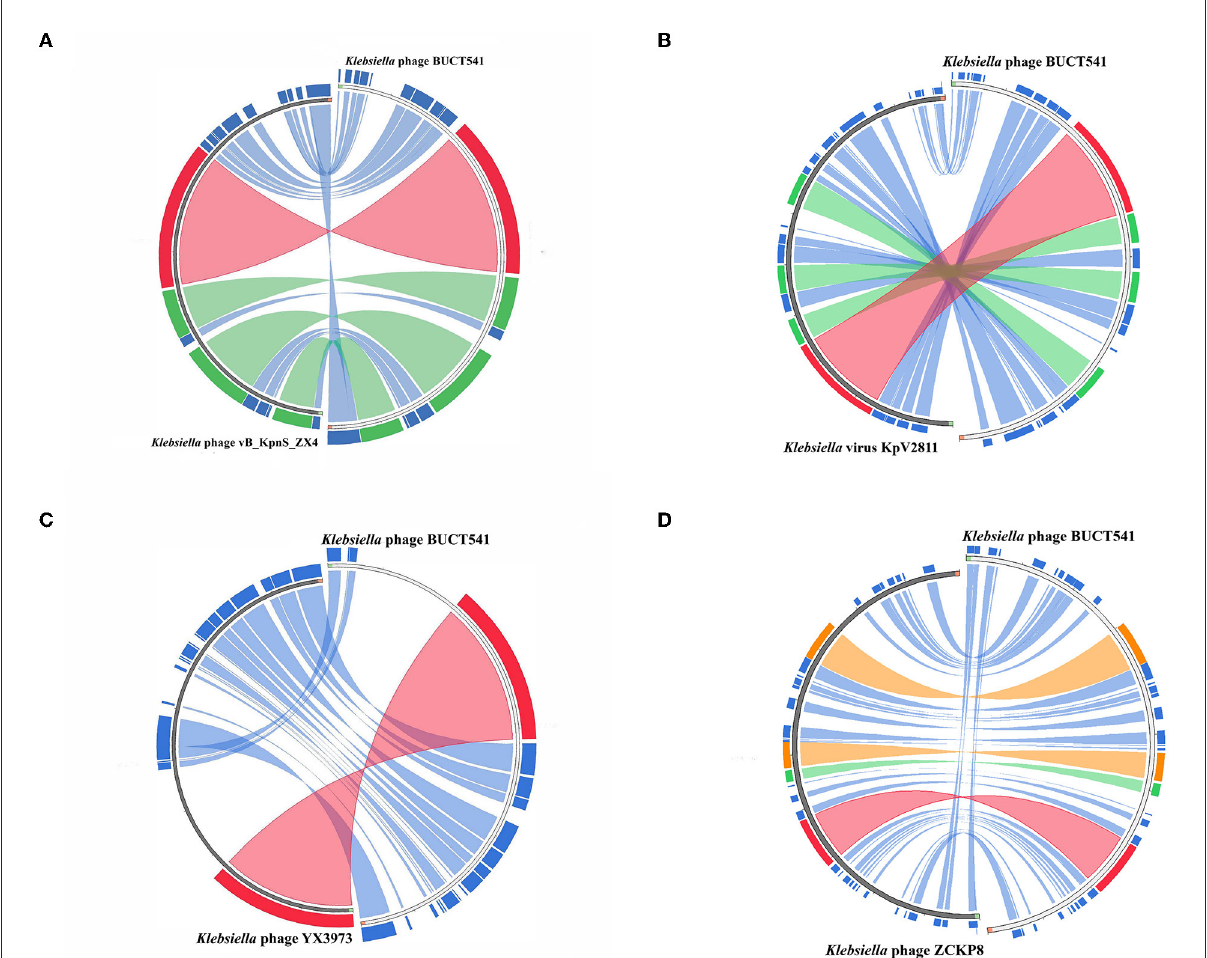
FIGURE4 Circos plot depicting sequence similarities of Klebsiella phage BUCT541 with (A) Klebsiella phage vB_KpnS ZX4, (B) Klebsiella virus KpV2811, (C) Klebsiella phage YX3973, and (D) Klebsiella phage ZCKP8. The red color signifies a high sequence similarity followed by orange, green, and blue. Ratio coloring with blue ≤ 0.25, green ≤ 0.50, orange ≤ 0.75, and red > 0.75.